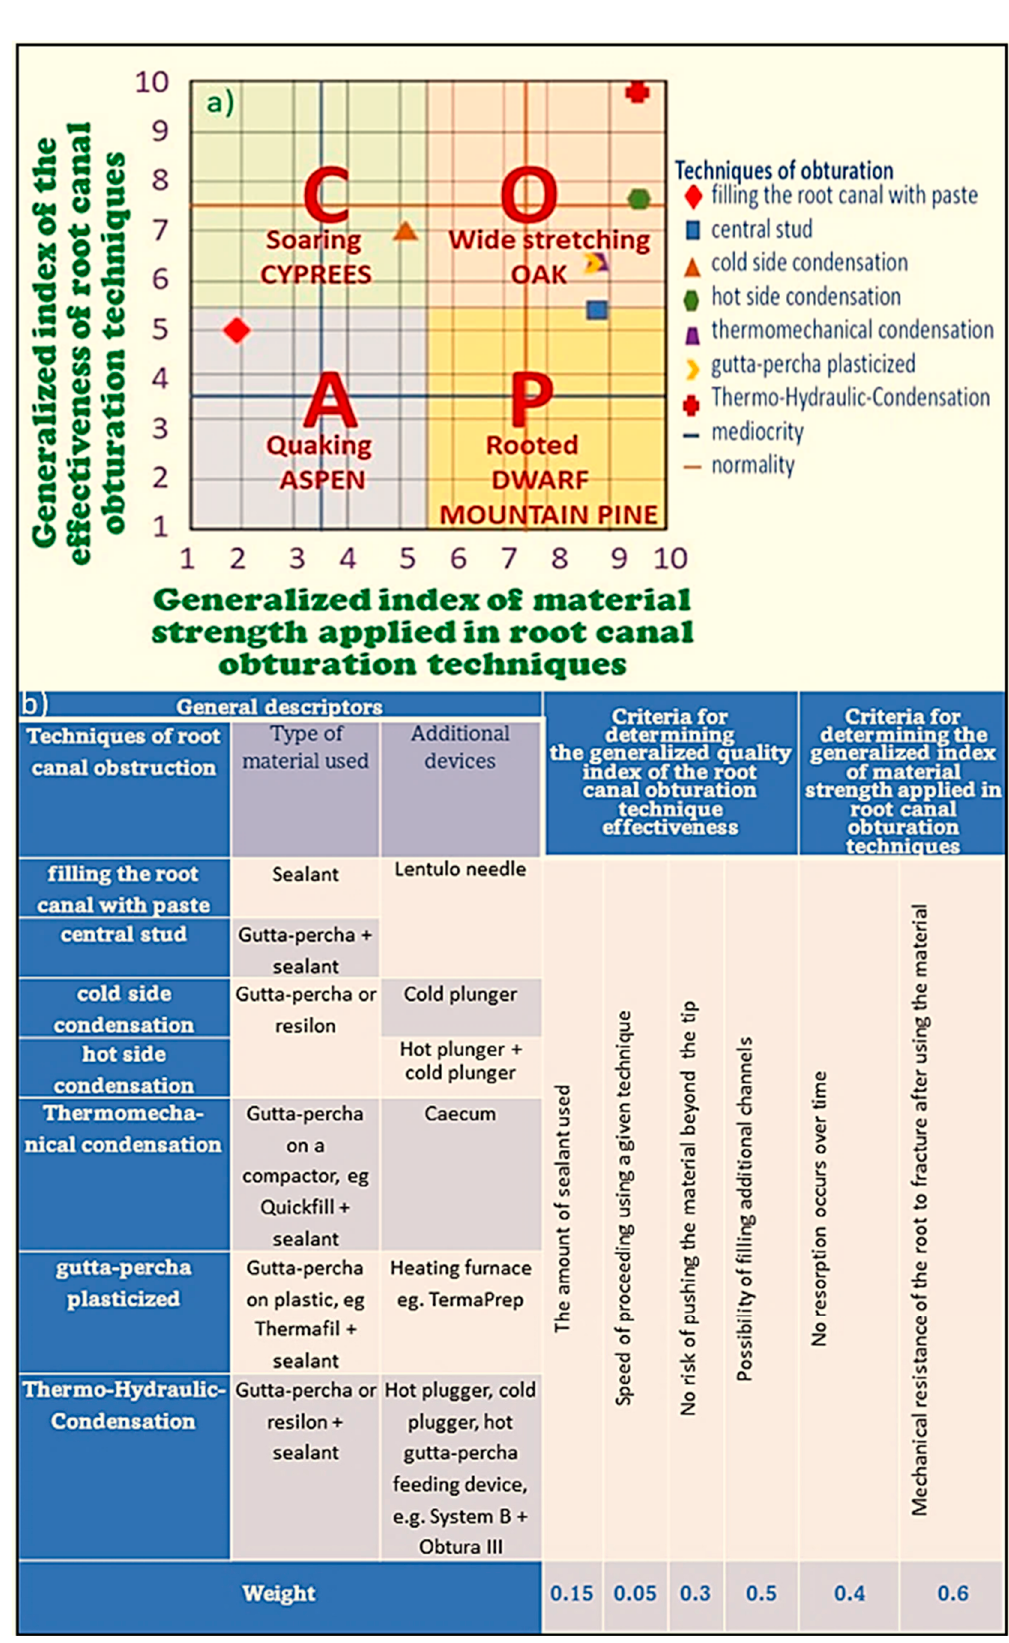
Figure 11. Contextual matrix of attractiveness ( a ) of virtual contextual analysis concerning methods of root canal obturation and a set of criteria for expert assessment ( b ).